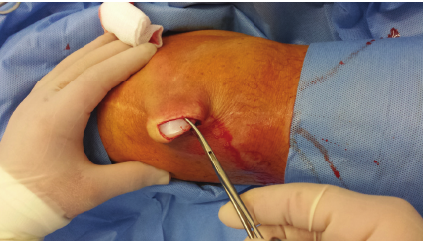
Figure 2: Clinical photo of the right knee showing a swelling anterior to the patella.